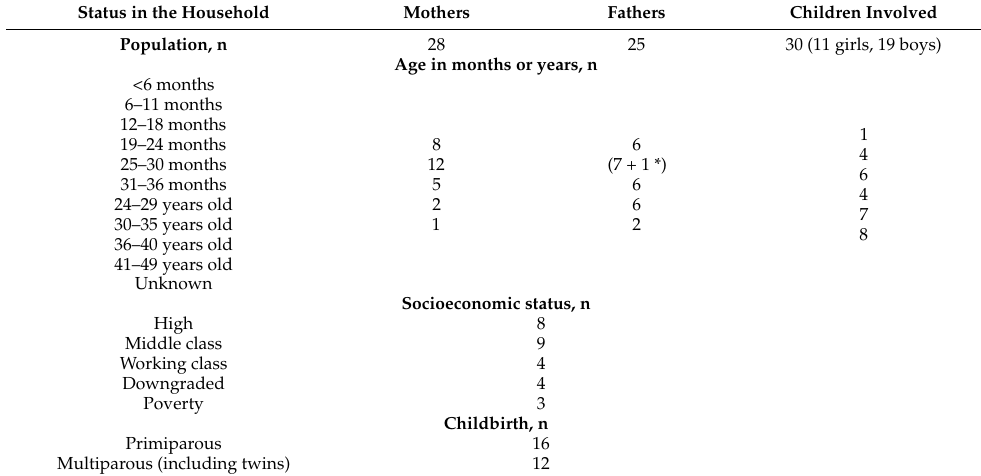
Table 1. Socioeconomic characteristics of